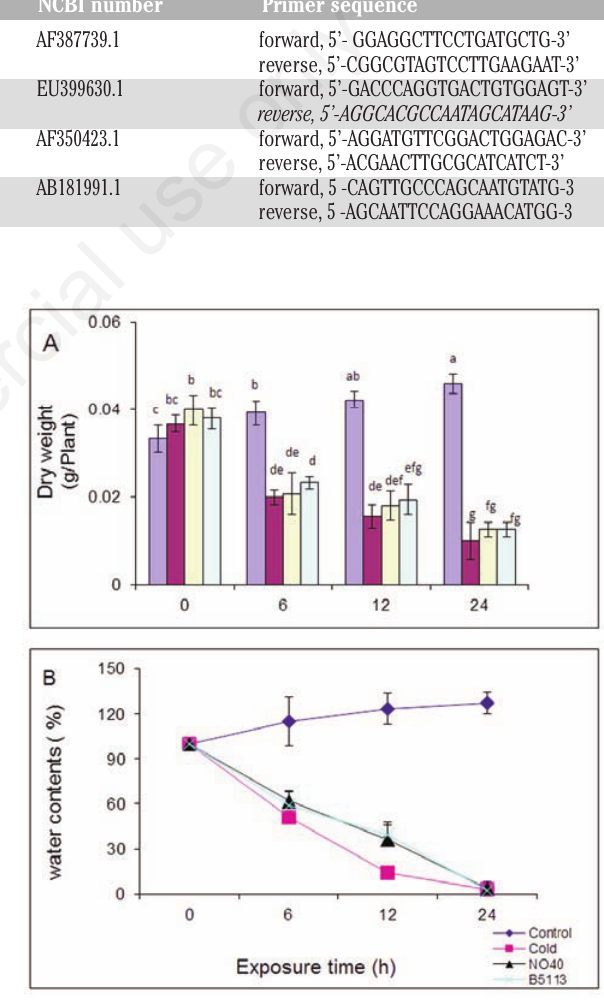
Figure 2. Effect of bacterial priming on some growth parameters of chilling stressed wheat Bacterial priming with B. amylolique- faciens 5113 or A. brasilense NO40 were tested for effects on growth parameters of wheat seedlings (cv. Sids 1) subjected to −5°C chilling stress for 0, 6, 12 and 24h. Bars indicate standard errors between six replicates. Treatments labelled with identical letters are not significant at P ≤ 0.01. A) Shoot dry weight (g/plant); B) shoot water content